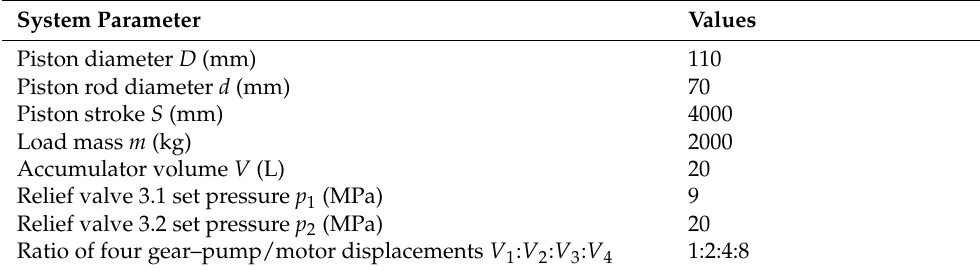
Table 3. Major parameters of the hydraulic